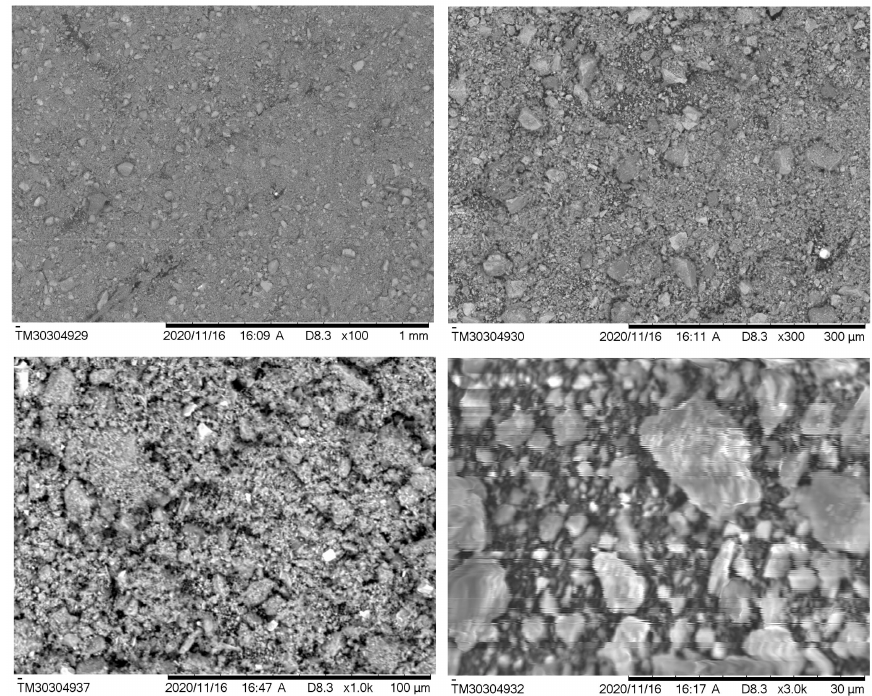
Figure 4. Electronic micrographs of the samples of manganese ore from the Zhaksy